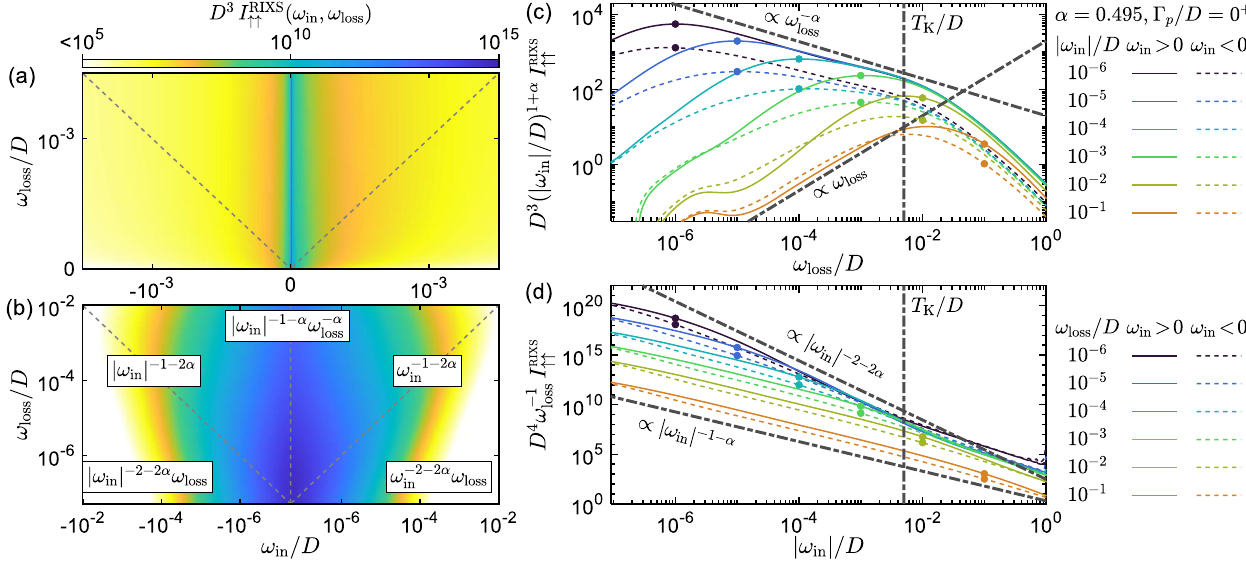
; ω FIG. 12. RIXS spectrum I RIXS ↑↑ ð ω for the AAIM (same parameters as for Fig. 11). The layout is the same as for Fig. 9. The in loss Þ spectrum I RIXS ↑↓ (not shown) is qualitatively similar, exhibiting the same power